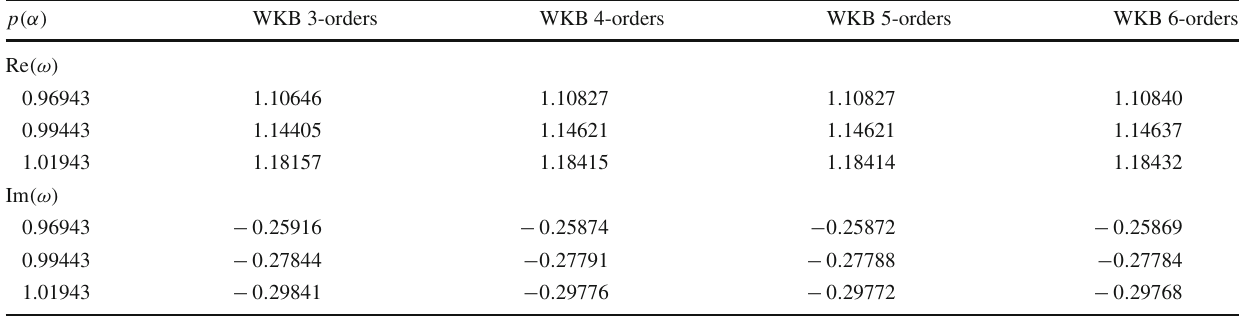
Table 1 The dependence of the real and imaginary parts of the quasinormal frequencies for the scalar field ( s = 0) on the dimensionless parameter p for l = 2